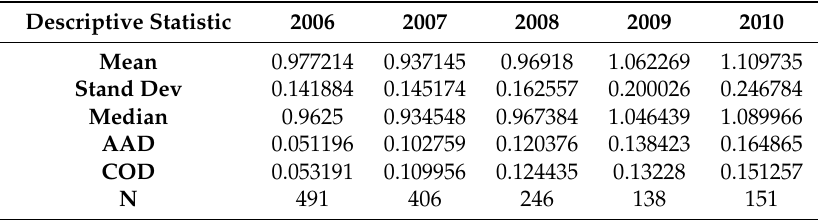
Table 4. Overall ratios descriptive statistics for all qualified sales in